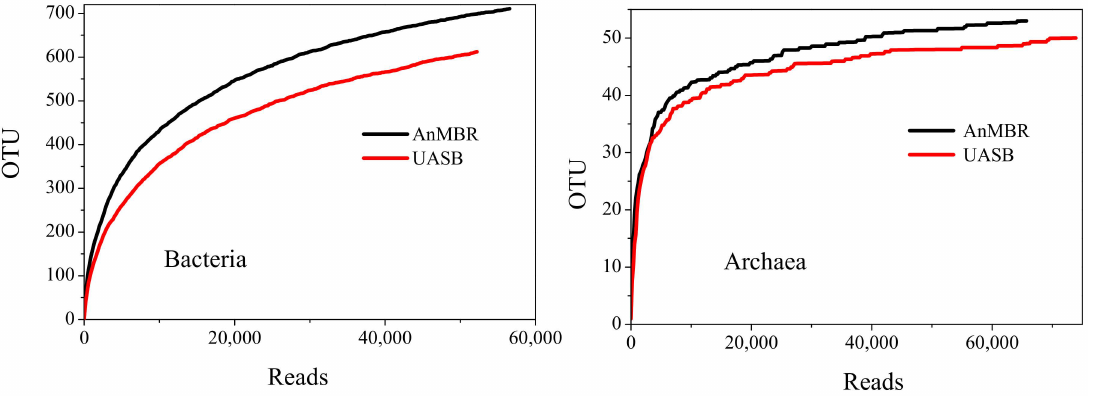
Figure 6. The rarefaction curves of the bacteria and archaea in the studied AnMBR and